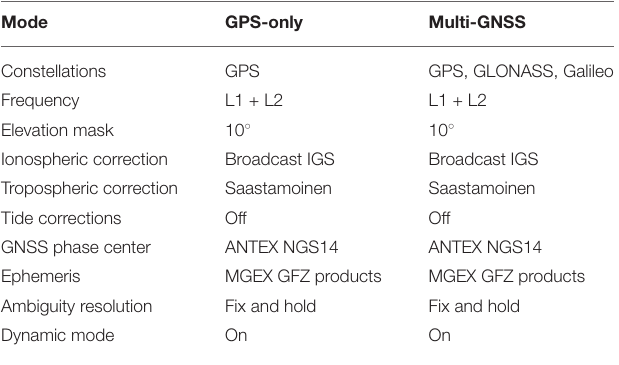
TABLE 1 | GNSS post-processing